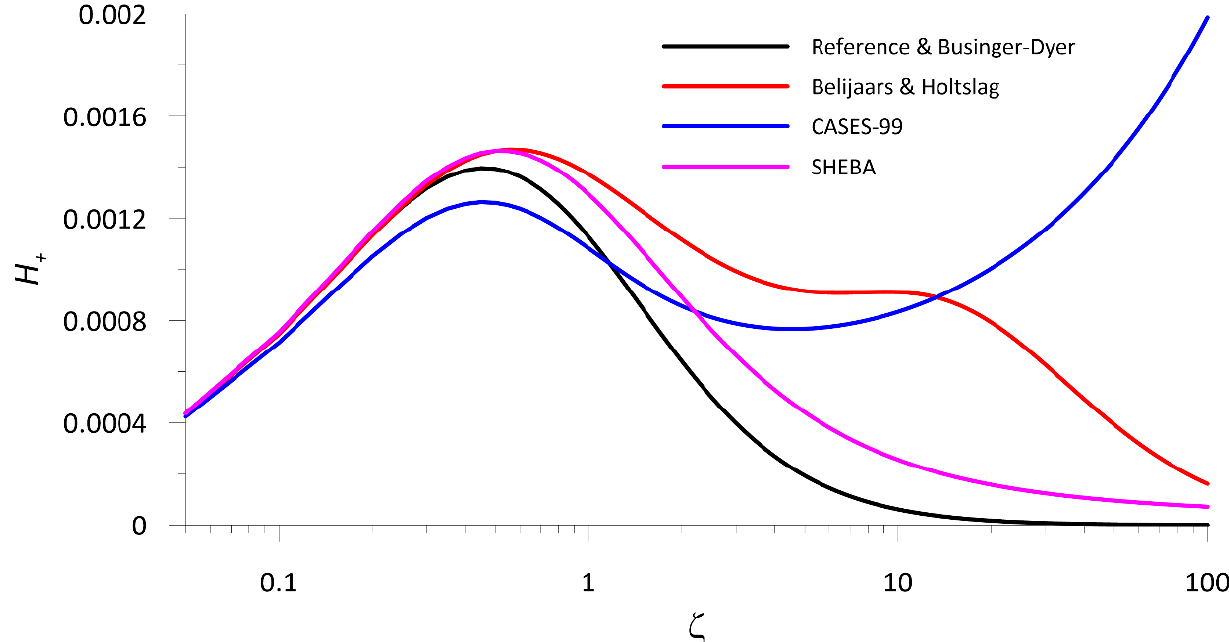
Figure 4. Evolution of the absolute value of H + as a function of the stability parameter ζ for the four Ψ m listed in Section 3 (z 0 = 0.5